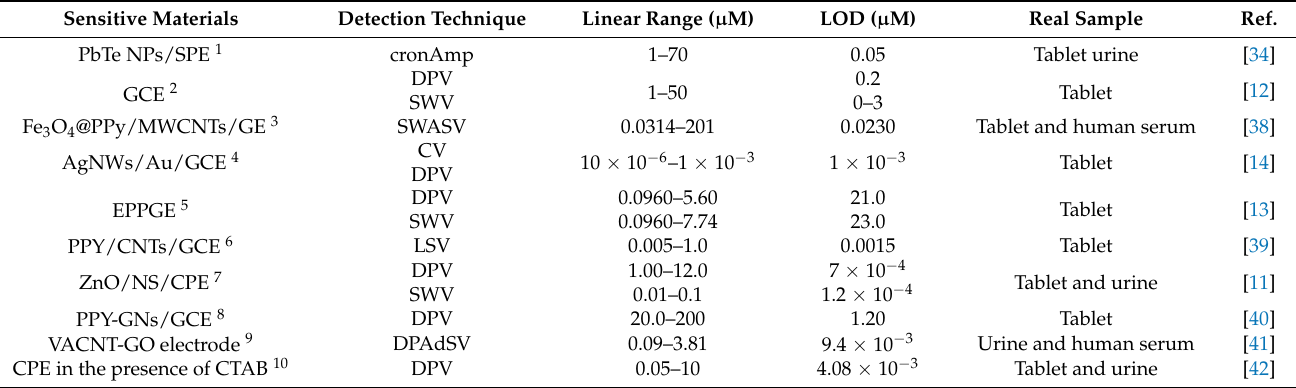
Table 5. Sensitive materials, detection technique, linear range and LOD of some sensors used for the detection of atorvastatin. Sensitive Materials